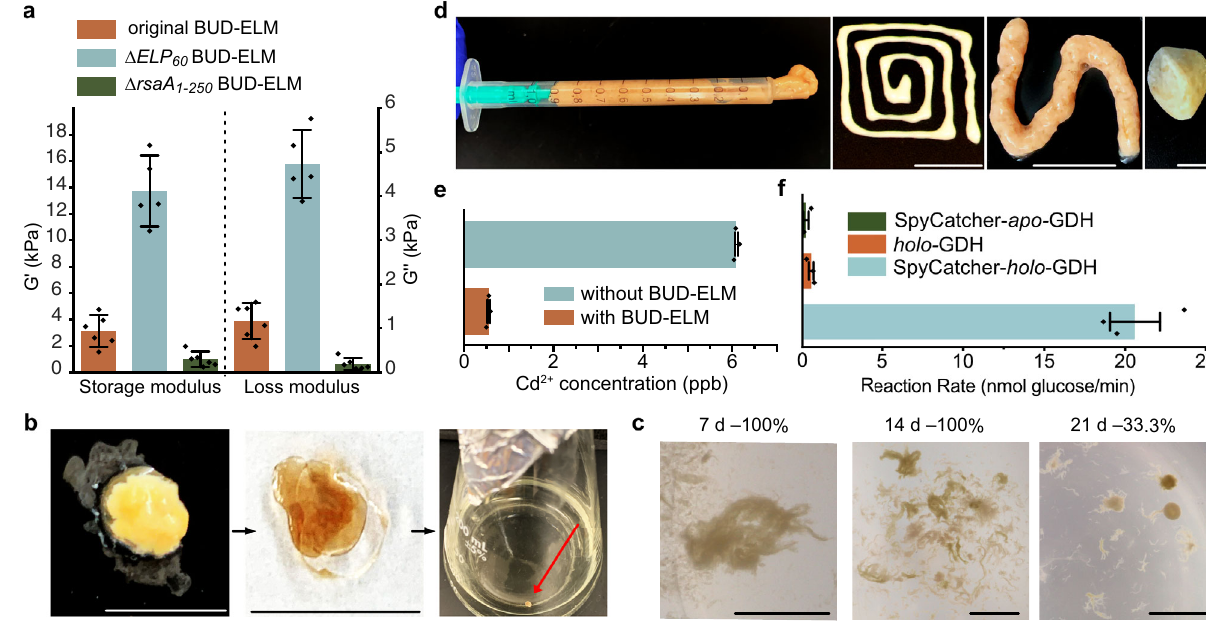
Fig. 4 | BUD-ELMs are self-regenerating, processible, and functional materials. a Storage (G ’ ) and Loss (G ” ) modulus of original, Δ ELP 60 and Δ rsaA 1 – 250 BUD-ELMs at an angular frequency of 10rads − 1 , showing differences among the three BUD- ELMs. Error bars are centered on the mean value and represent 95% con fi dence intervalsofatleast fi veindependentsamples.SourcedataareprovidedasaSource Data fi le. b ReseedingprocessofBUD-ELMs,showingextractionfromliquidculture (left),desiccated(middle)andinoculationintofreshmedium(right).Scalebarsare 1cm. c RepresentativeexampleofBUD-ELMsgrownfromdesiccatedmaterialafter 7 (left), 14 (middle), or 21 (right) days. The percentage of successful BUD-ELM regeneration was 100, 100, and 33.3%, respectively. Percentages are calculated fromatleastninesamples.Scalebarsare1cm. d BUD-ELMscollectedintoasyringe (left)forextrusionusingdifferent-sizednozzles(twomiddlepanels),showingtheir